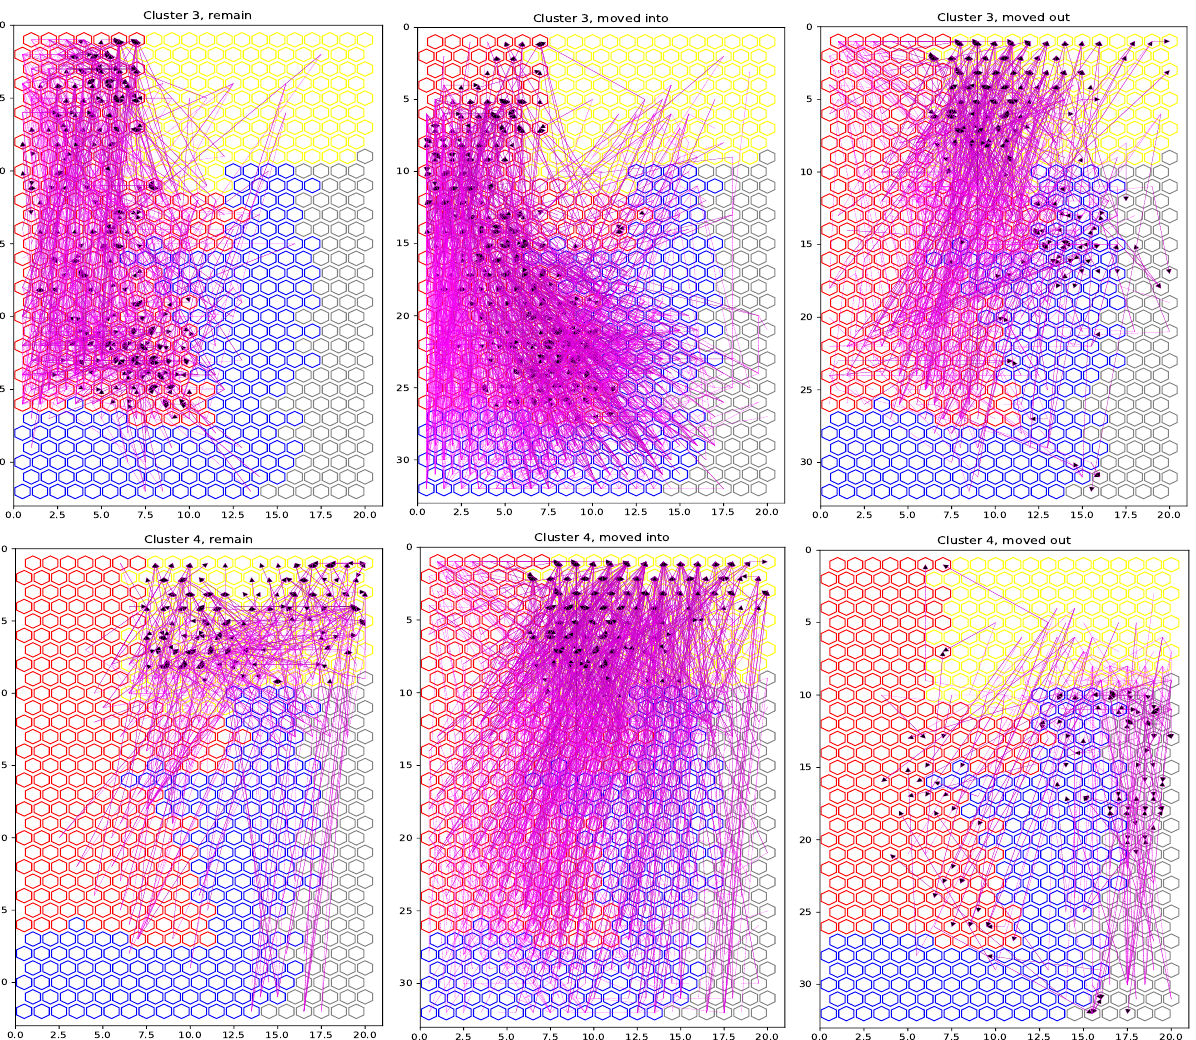
Figure A5. Visualization of longitudinal trajectories (part II). Cluster 1 is represented in gray; Cluster 2 in blue; Cluster 3 in red; and Cluster 4 in